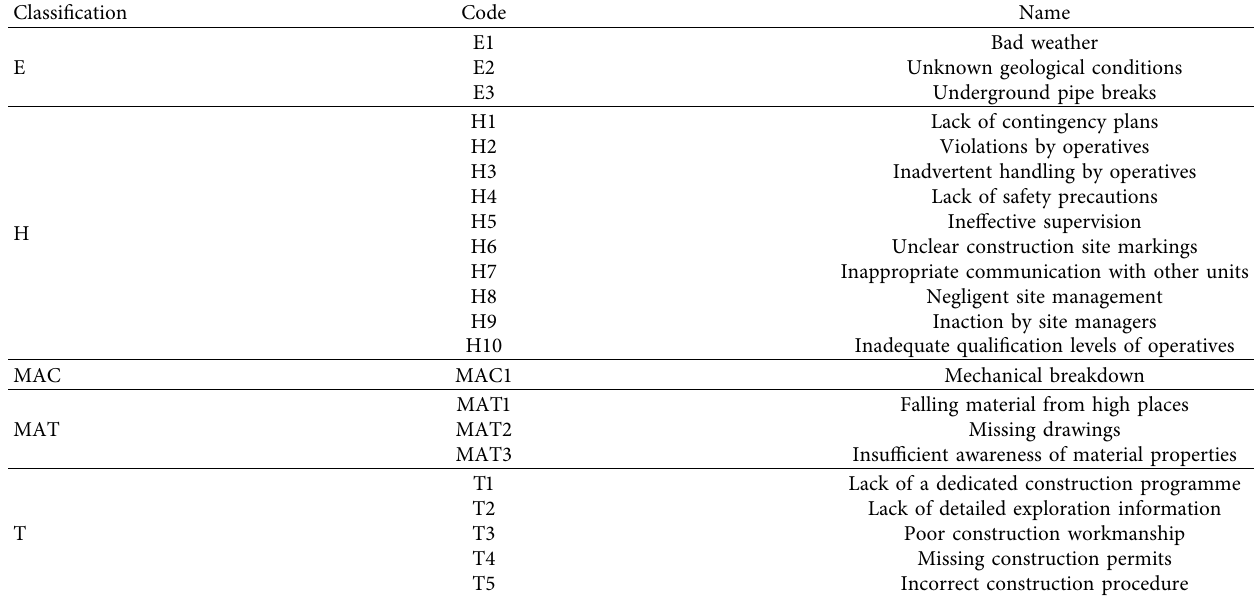
Table 5: Metro construction safety risk